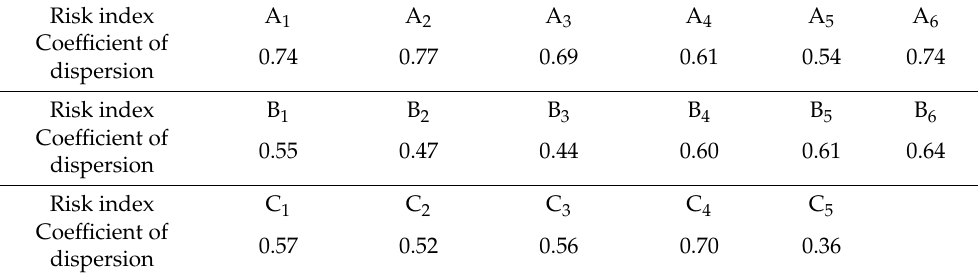
Table 3. Coefficient of dispersion of ICCL safety supervision index.